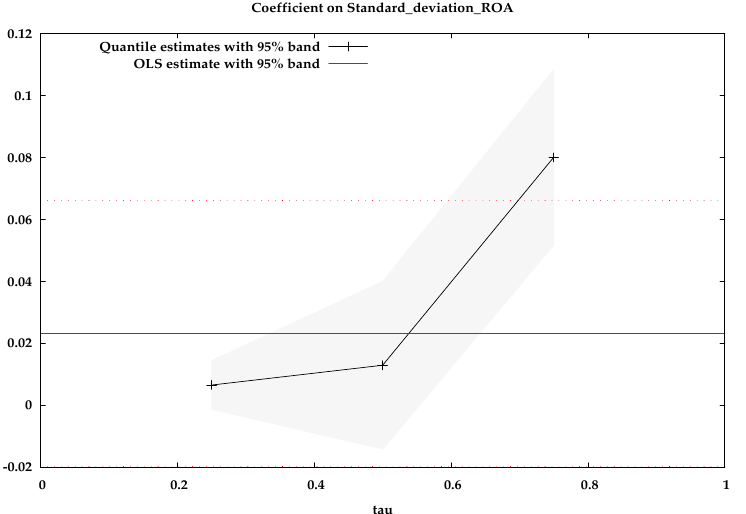
Figure 2. Coefficients across the quantiles with the bootstrapped confidence intervals for regression of standard deviation of returns vs. standard deviation for ROA ( τ = 0.25;0.5;0.75, the OLS confidence interval is from − 0.0196 to 0.0661).